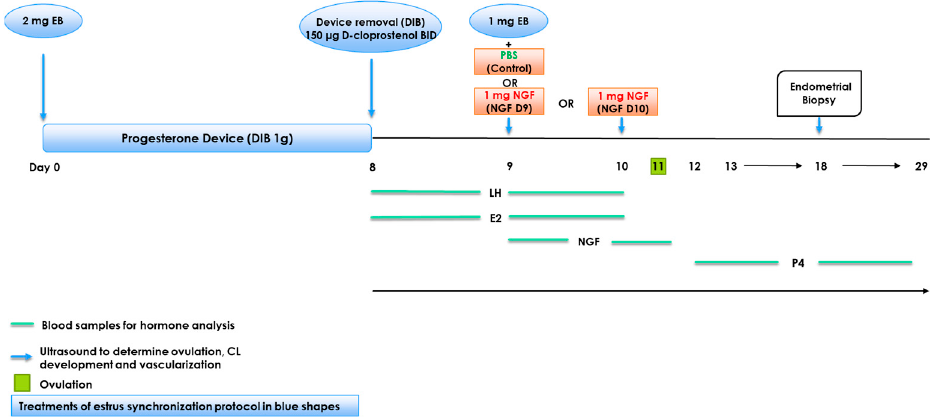
Figure 1. Experimental design of estrus synchronization protocol, treatments, and blood collection.